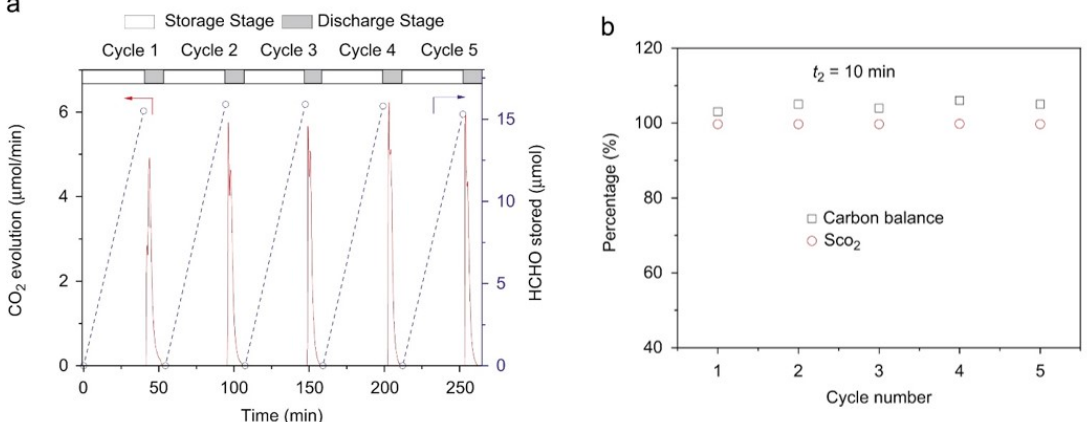
Figure 21. Comparison of ( a ) CO 2 evolution and HCHO storage and ( b ) carbon balance and CO 2 selectivity in five ‘adsorption–plasma discharge’ cycles. Reprinted from Reference [44], with permission from Elsevier.